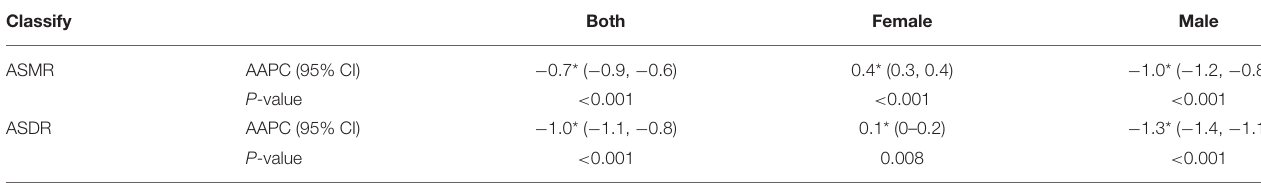
TABLE 3 | Trends in age-standardized mortality rates (ASMR) and age-standardized DALYs rates (ASDR) of TBL cancer, 1990–2019.